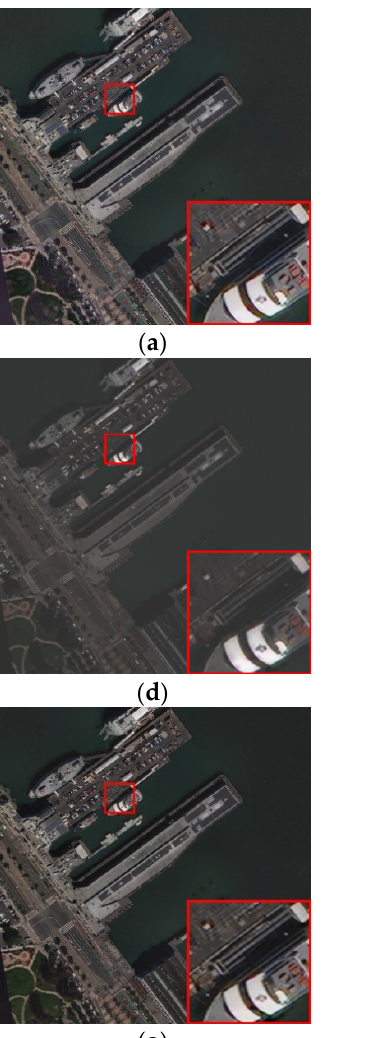
Figure 13. Real experiment results using the WorldView-2 dataset. ( a ) IHS, ( b ) HPF, ( c ) PRACS, ( d ) Wavelet, ( e ) PNN, ( f ) FusionNet, ( g ) Pansformers, ( h ) LNFIN, ( i ) LRMS.